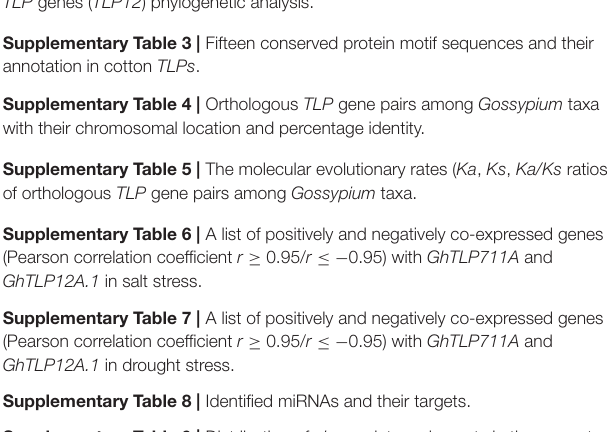
Supplementary Figure 4 | Co-expression network analysis of GhTLP11A and GhTLP12A.1 genes. Positively and negatively co-expressed genes (PCoEGs and NCoEGs) with GhTLP11A and GhTLP12A.1 in salt and drought stress at different time scales. Rhombus (nodes) represents transcripts, and lines (edges) represent transcriptional interaction between GhTLPs and transcripts. Supplementary Figure 5 | PageMan-based functional classification of Positively and negatively co-expressed genes (PCoEGs and NCoEGs) in transcriptional regulation, signaling, lipid metabolism, stress, signaling, secondary and hormone metabolism in (A,B) salt- and (C,D) drought-stress condition at 0, 6, 12, 24, 48, and 72h. BINs colored in green and red are positively and negatively regulated groups, respectively. Expression values in the log 2 scale indicated by the scale bar. Supplementary Table 1 | Reciprocal blast of cotton and A. thaliana TLP proteins. Supplementary Table 2 | A list of eudicots plants used for groups 4 and 8 cotton TLP genes ( TLP12 ) phylogenetic analysis. Supplementary Table 3 | Fifteen conserved protein motif sequences and their annotation in cotton TLPs .